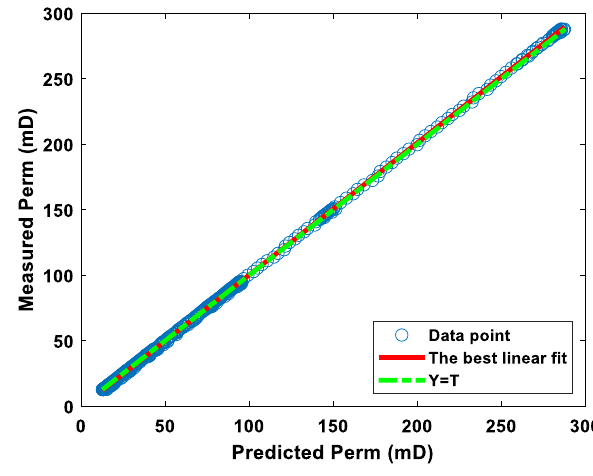
Fig. 14 Cross-plot of the measured and predicted values of perme- ability achieved by the MELM-COA model in the studied depth inter- val of well B